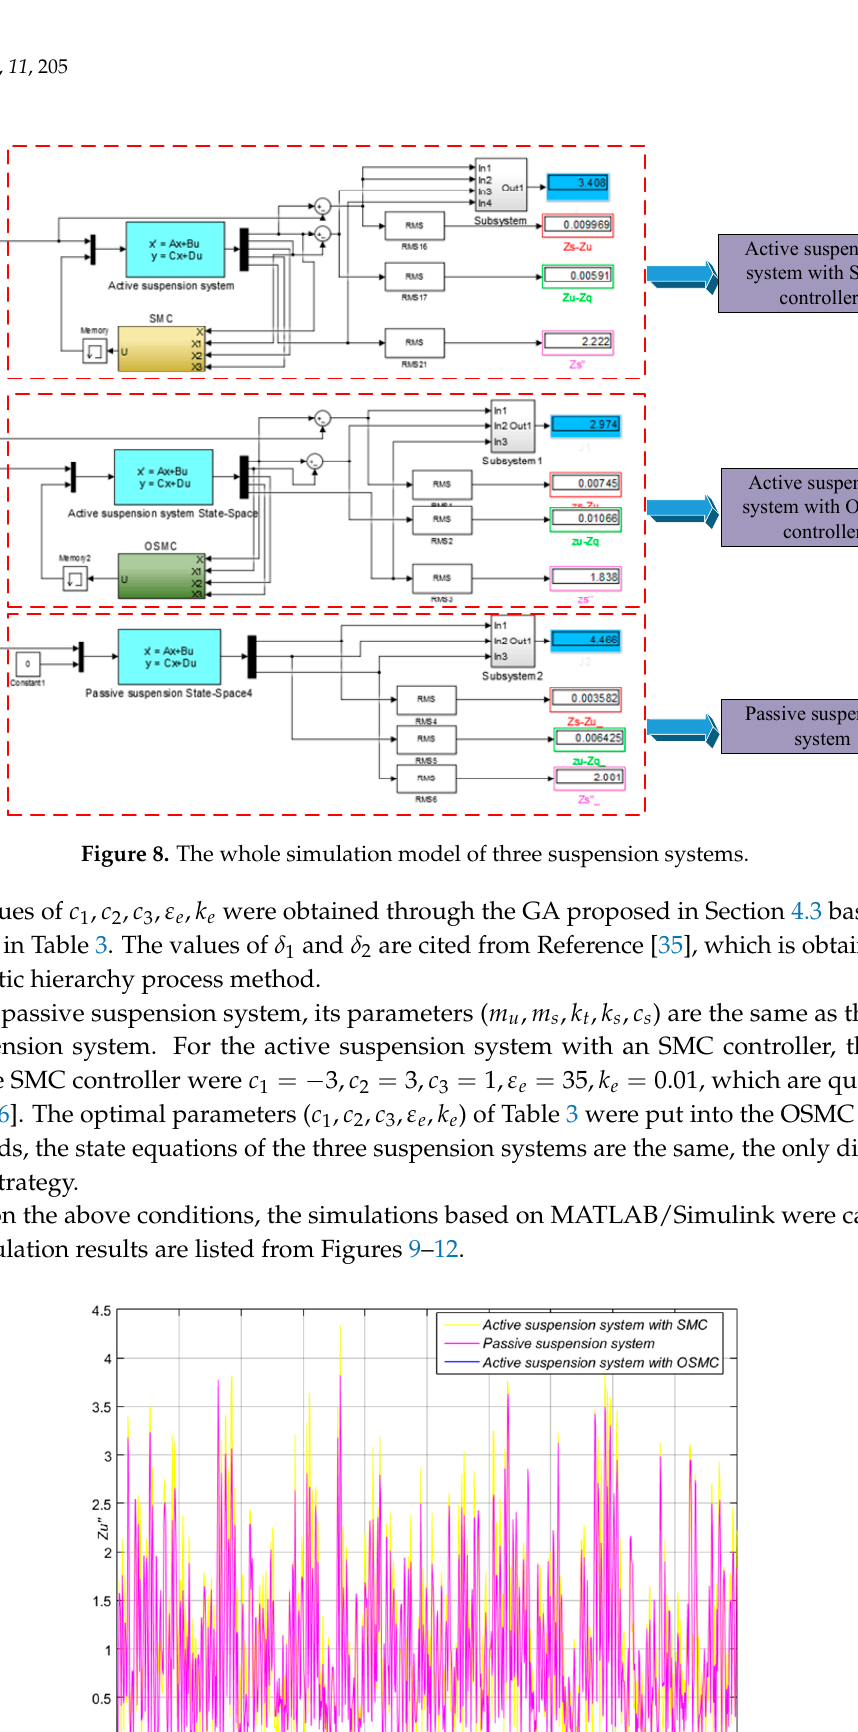
Table 3. The actual parameters of the quarter suspension system.